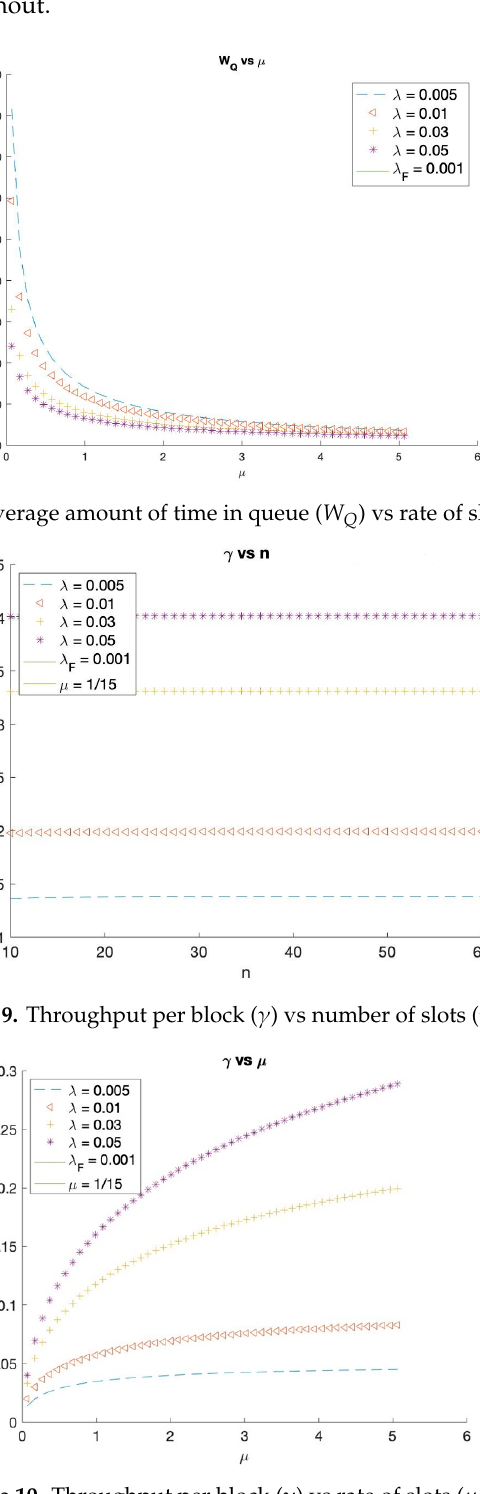
Figure 10. Throughput per block ( (cid:2011) ) vs rate of slots ( (cid:2020) ).